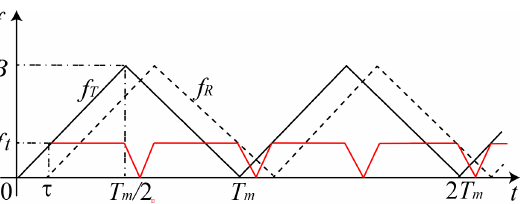
Figure 3. FMCW detection principle based on triangle wave frequency